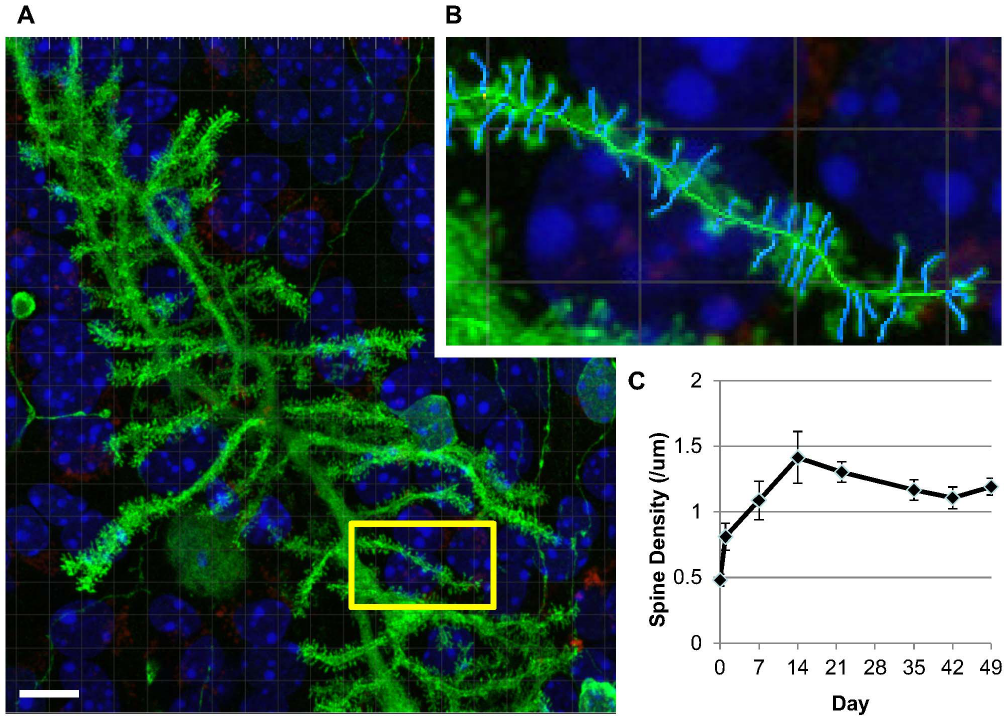
Figure 2. Purkinje cell spine density analysis; stability in uninfected cerebellar slice cultures from C57Bl6 mice. A,B) Representative Z- stacked image of a Purkinje cell as analyzed with Imaris 7.1.1 software, after deconvolution with ImageQuant X. B) Inset of A showing dendritic spine analysis; spines identified in blue. Nuclei are stained with Hoechst (blue), dead cells are stained with propidium iodide (red) and Purkinje cells are labelled with calbindin/Alexafluor488 (green). Scale bar 10 m m. C) Average spine density from uninfected cerebellar cultures from C57Bl6 mice at weekly time points. Errors bars represent one standard error of the mean. n=9 except day 14 where n=3. doi:10.1371/journal.pone.0081776.g002 gold with DAPI (Invitrogen) were placed on the membrane insert and a coverslip was affixed to the slide. Slides were cured a minimum of 24 hrs.